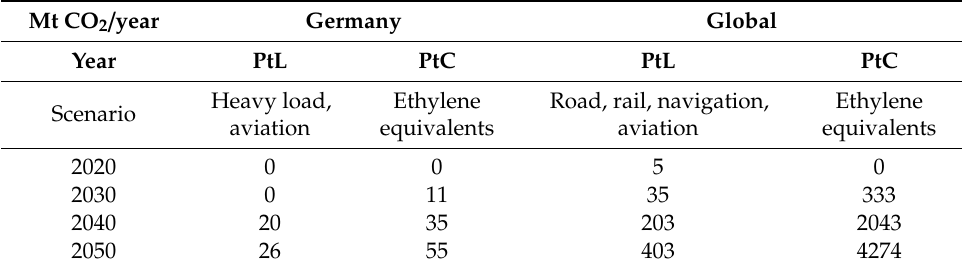
Table 3. German and global CO 2 demand for carbon-neutral production of Power-to-Liquids (PtL) and Power-to-Chemicals (PtC) by 2050 in Mt CO 2 /